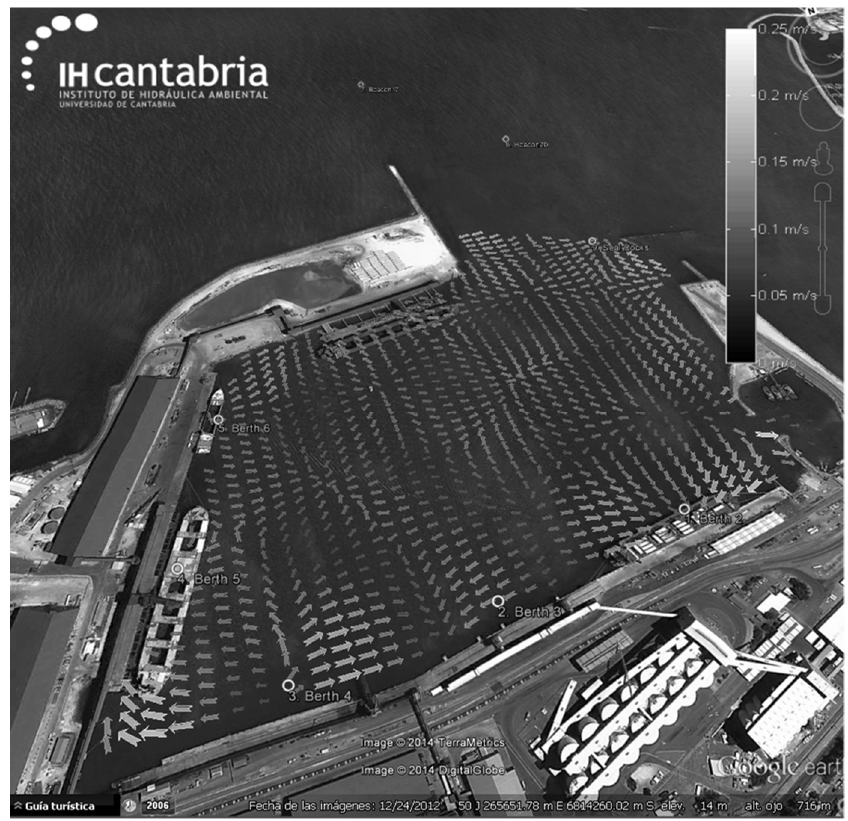
Figure 10. Snapshot for the maximum long wave-induced current of the 27 August 2007 inoperability event at Geraldton Harbor, obtained with the MANOLO model.